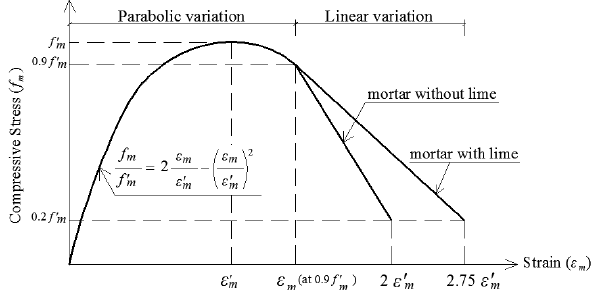
Fig. 4. A four nodded shell element and in plane stresses. (SAP2000 reference manual).